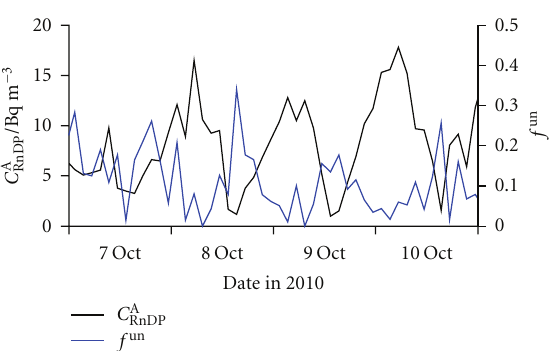
Figure 9: Diurnal variations of the equilibrium equivalent activity concentration of radon decay products ( C A unattached decay products ( f un ), in outdoor air for the period October